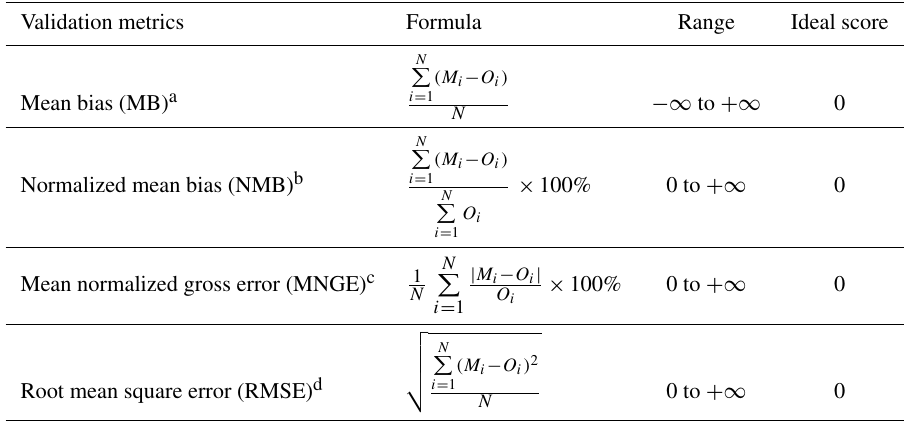
Table A1. Error statistics used to evaluate the model performance ( M and O refer, respectively, to model and observation data, and N is the number of